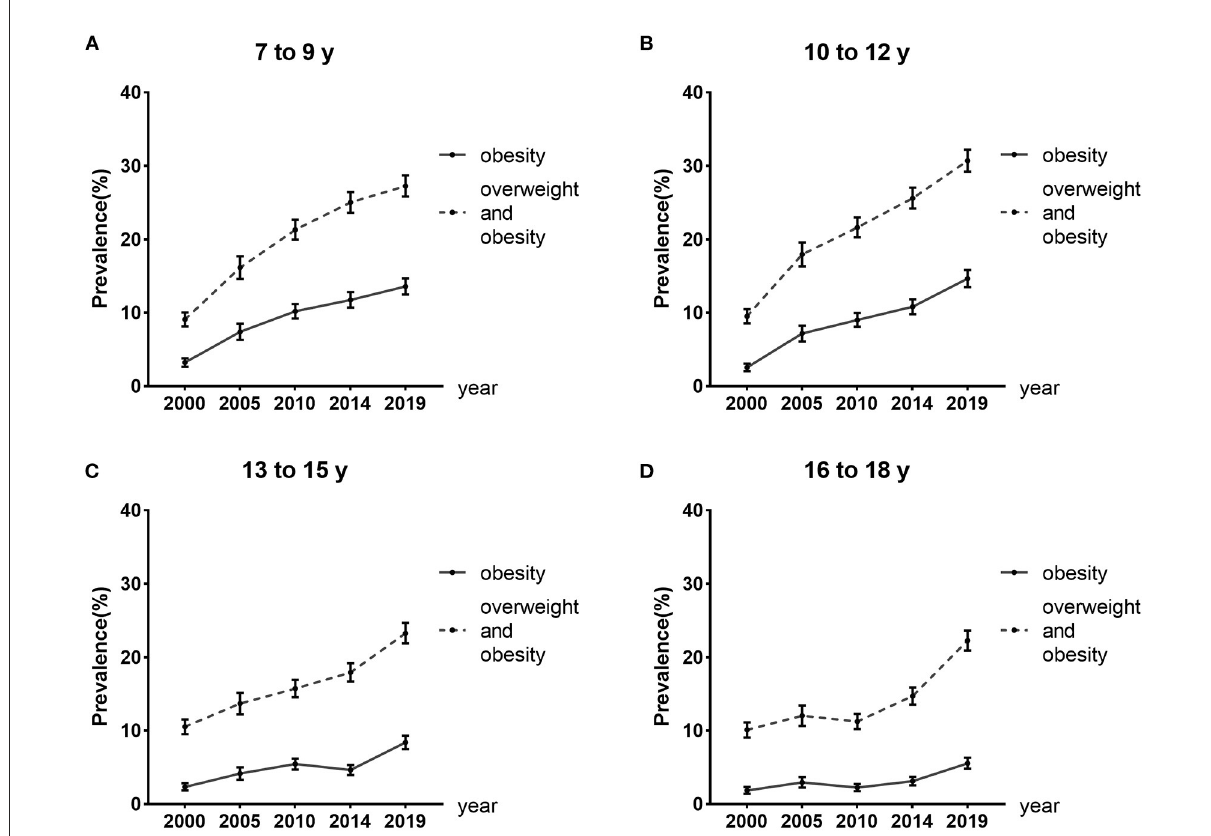
FIGURE1 Trends in overweight and obesity prevalence from 2000 to 2019 in different age groups. Error bars represent 95% confidence intervals.